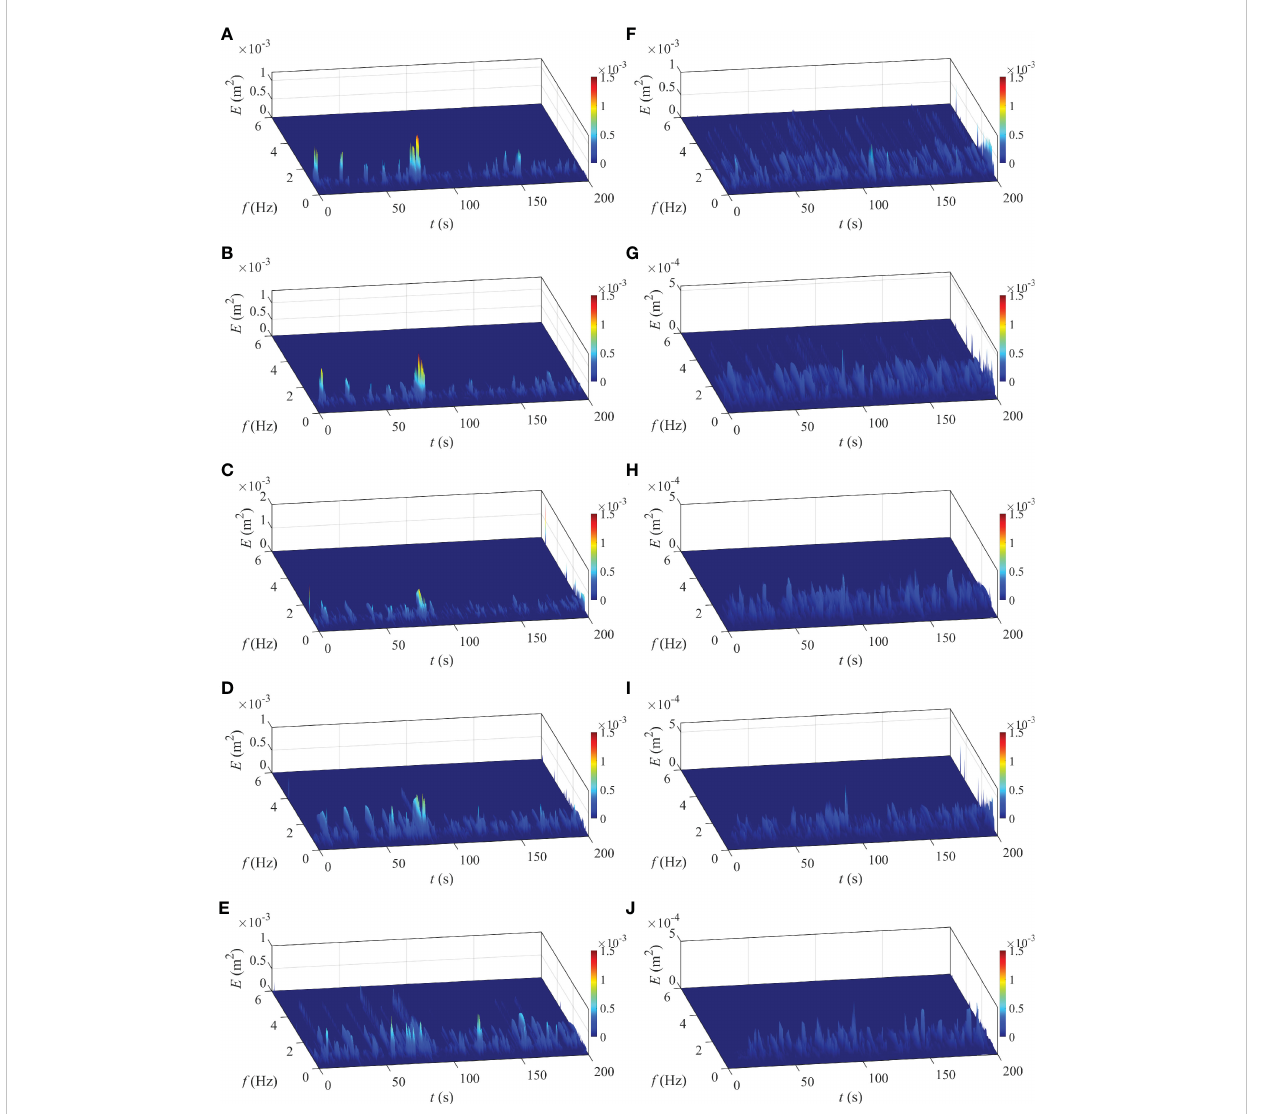
FIGURE 10 Evolutions of the three-dimensional Hilbert spectra for the case RJ 7 at stations: (A) 2 # ; (B) 4 # ; (C) 6 # ; (D) 7 # ; (E) 8 # ; (F) 9 # ; (G) 10 # ; (H) 11 # ; (I) 14 # and (J) 17 # ; the freak wave occurs at station 7 #